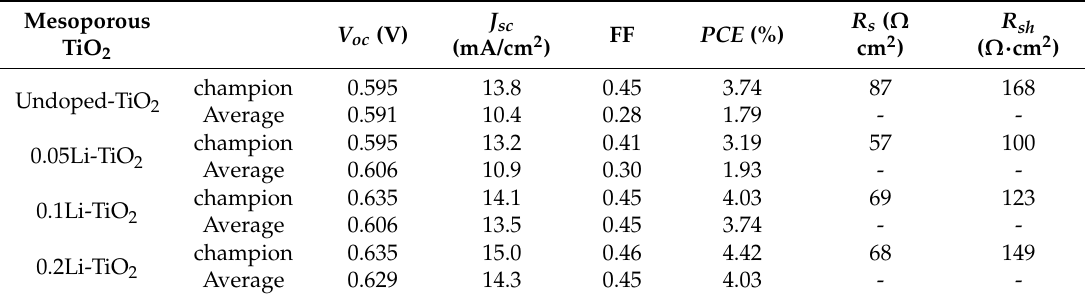
Figure 5. ( a ) The champion J-V curves of the devices based on different Li-doped TiO 2 and ( b ) EQE of the Sb 2 S 3 solar cells. Table 1. Photovoltaic parameters of the thermal-evaporated Sb 2 S 3 solar cells based on different mesoporous TiO 2 , measured under one Sun AM 1.5G